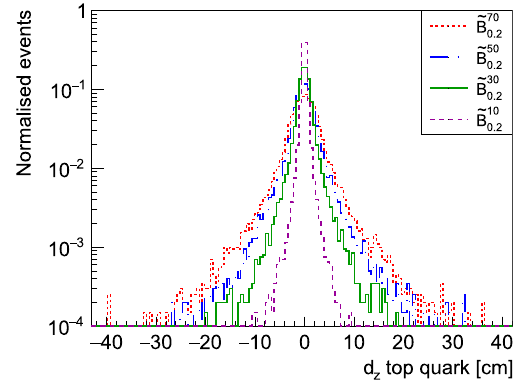
Fig. 11 Total transverse hadronic energy THT in the ˜ B -like case